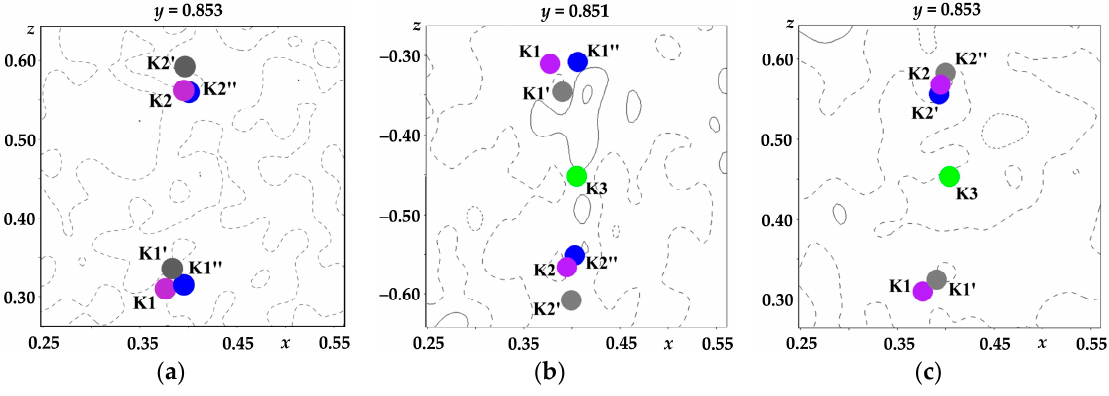
Figure 4. Difference maps of electron density in a channel after taking into account a statistical distribution of potassium atoms in the crystal structure of: ( a ) pure KTP [46]; ( b ) KTP:4%Nb; ( c )